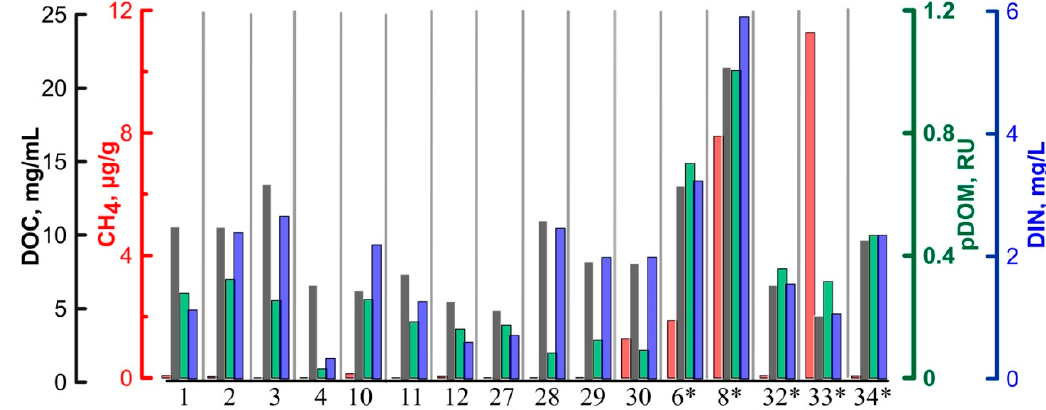
Figure 10. Distribution of the selected key biogeochemical factors in the ground ice samples. * -tabular ground ice (TGI) samples are marked with an astersisk